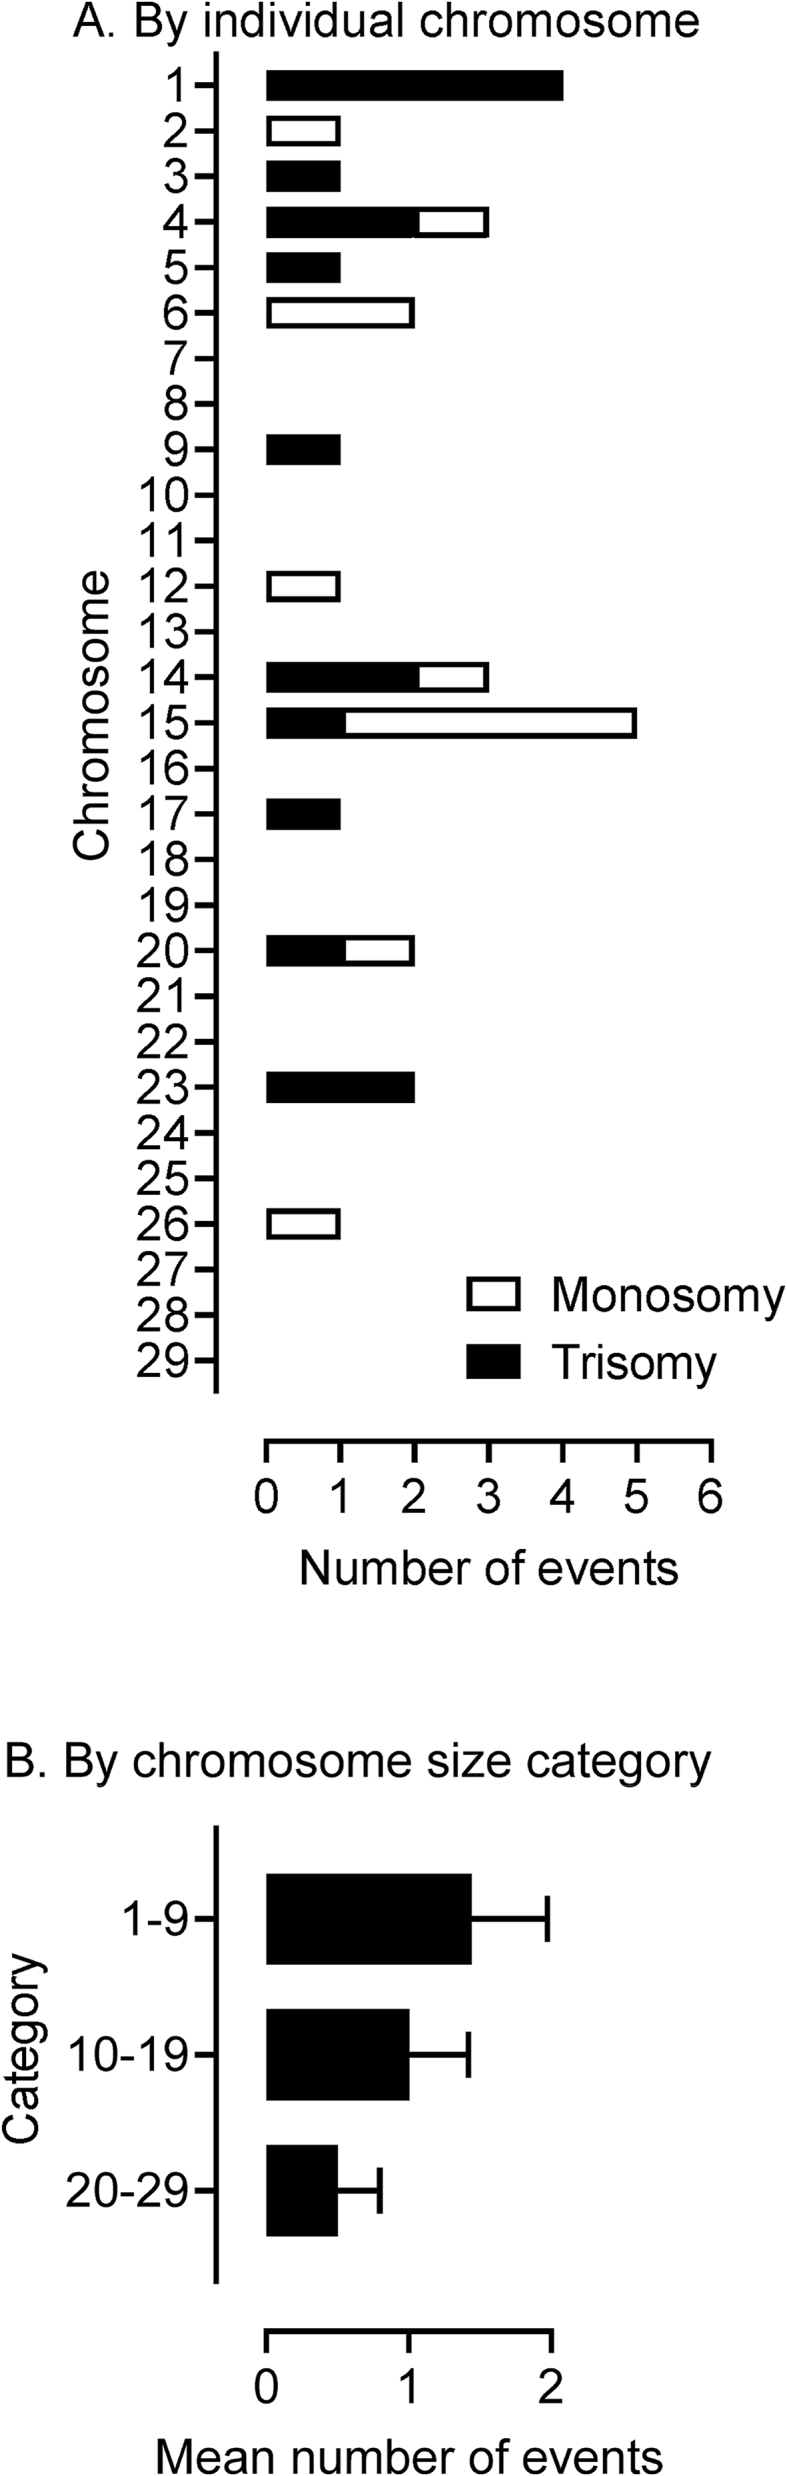
Chromosome-specific incidence of aneuploidy in blastocysts (n = 152). (A) Expressed by individual chromosome identifying incidences of monosomy and trisomy. (B) Combined aneuploidy categories grouped by ‘small (20–29), medium (10–19) and large (1–9)’ chromosomes. Data are for blastocysts from stimulated and non-stimulated cycles of OPU-IVP.